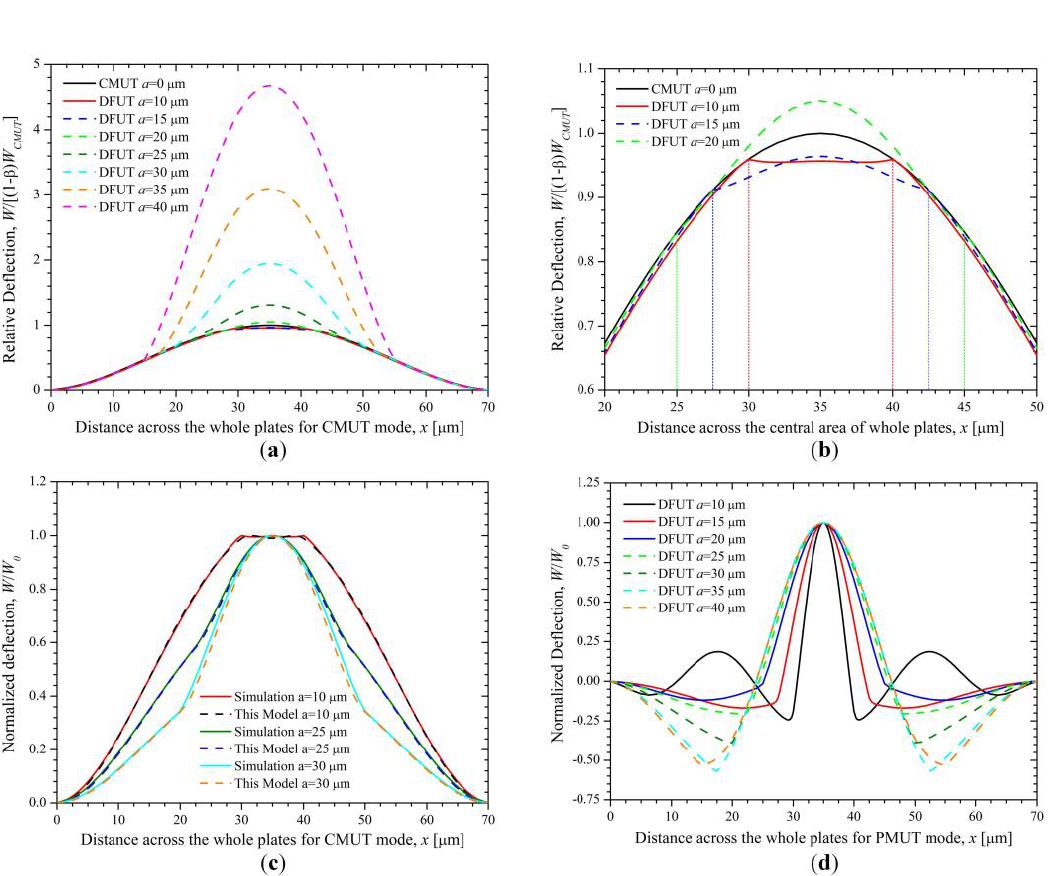
Figure 6. Relative deflection for CMUT mode, ( a ) across the whole plates; ( b ) a zoom-in view across the central region of the whole plates; ( c ) normalized deflection across the whole plates for CMUT mode; ( d ) normalized deflection across the whole plates for PMUT mode.